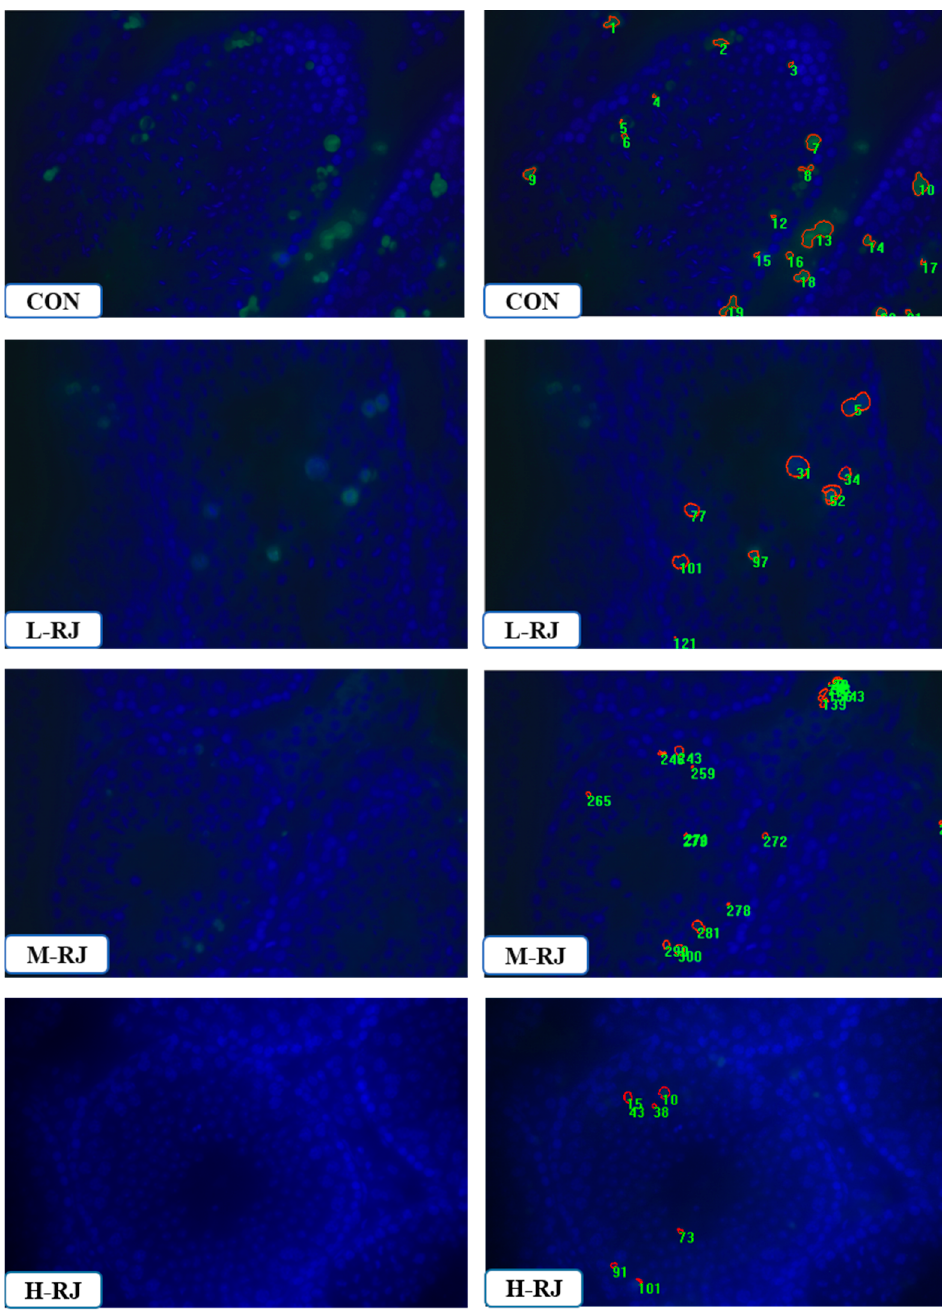
Figure 8. Administration of RJ reduced apoptosis in the testis. Apoptosis analysis of the CON and treatment groups. From top to bottom are the testis of CON, L-RJ, M-RJ and H–RJ, the left column showed apoptotic figures among groups, the right column were apoptotic cells in the figures which was labeled by IMAGE -PRO 6.0. Data collected using a Nikon DS-U3 system and Image-Pro Plus6.0 software. Statistical analysis was performed using Student’s t-test. Magnification: 40x.